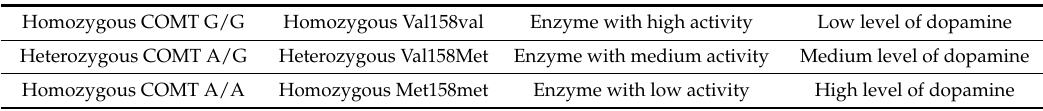
Table 1. Catechol- O -methyltransferase COMT enzyme and its three phenotypes activities (COMT-475G > A or rs4680 G > A or Met158Val gene